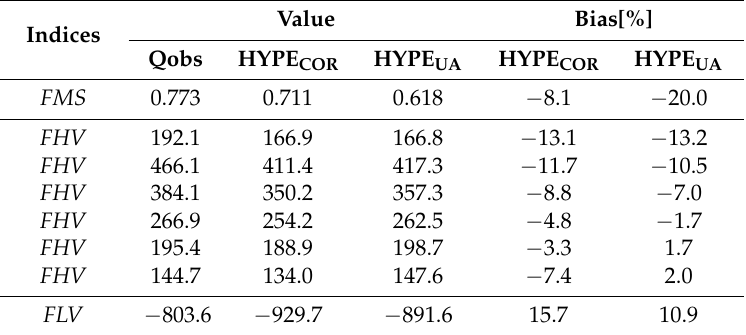
Figure 7. Flow duration curves calculated from observed flow rate, HYPE COR flow rate and HYPE UA flow rate. Table 4. Indices related to low, medium and high flow exceedance probability in the FDC.